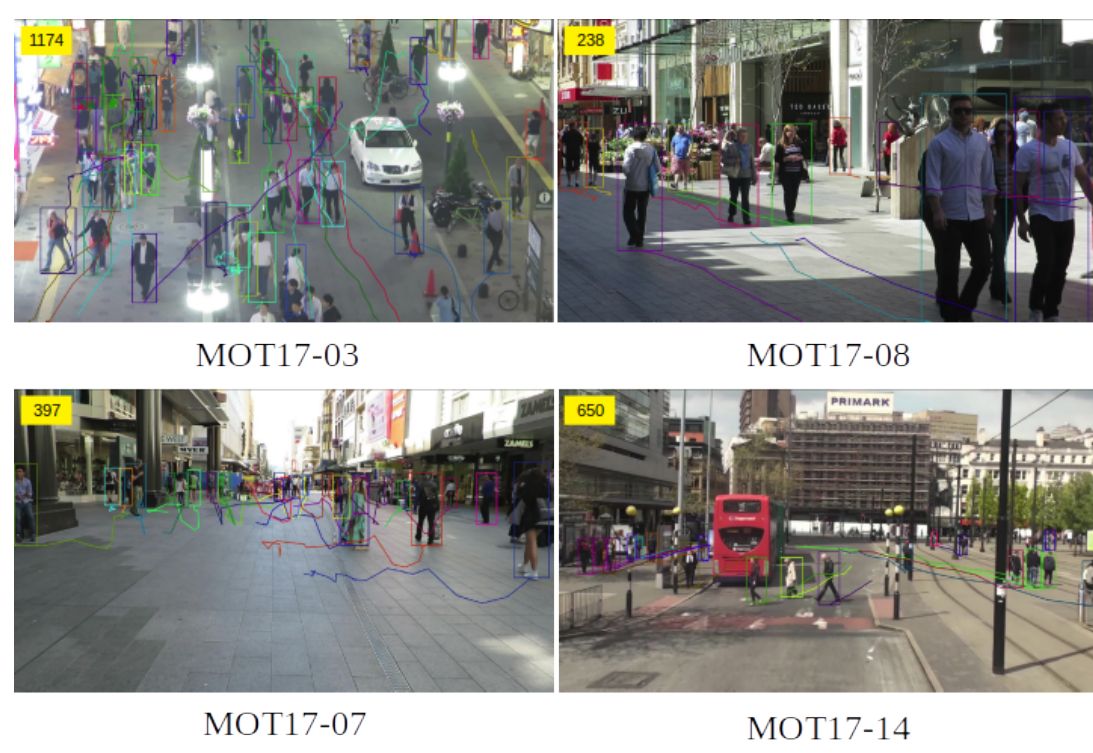
Figure 6. Visualization of selected sequences from the MOT17 benchmark